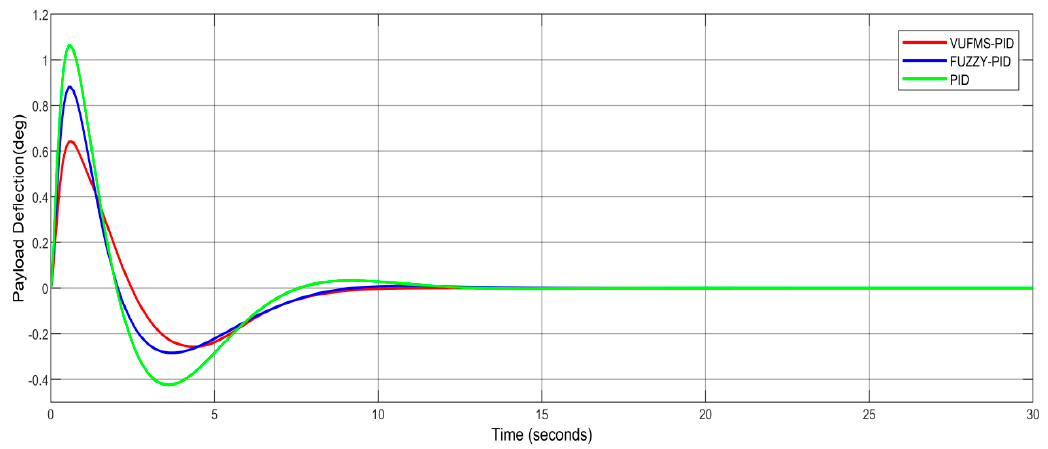
Figure 7. Overhead crane’s swing angle ( θ ) VUFMS-PID, FUZZY-PID and PID controller. Table 4. Performances obtained using VUFMS-PID, FUZZY-PID and PID controller for the bridge crane. Output Performances